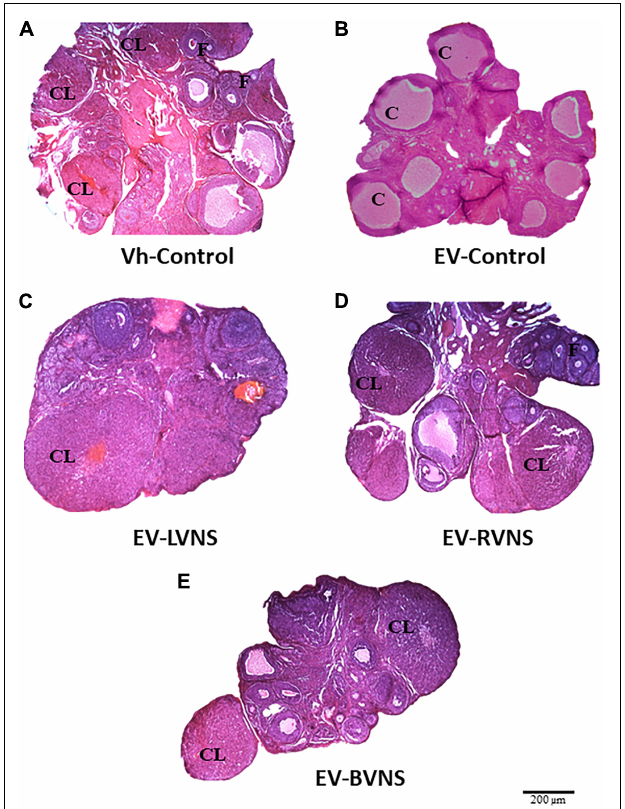
FIGURE 1 | Ovarian histology in EV-induced PCOS rats after unilateral or bilateral vagotomy. Micrographs correspond to the largest section (10 µ m thick) of the ovary from rats sacrificed the day of vaginal estrus (hematoxylin-eosin stain). (A) Ovary from a Vh-treated rat. (B) Polycystic ovary in an EV-treated rat. (C–E) Ovary from an EV-treated rat submitted to unilateral (LVNS or RVNS) or bilateral (BVNS) vagotomy at day 76 of life and sacrificed at day 80–82 of life. F, normal follicle; CL, corpora lutea; C, follicular cyst. 4 × microscopic lens. Scale bar = 200 µ